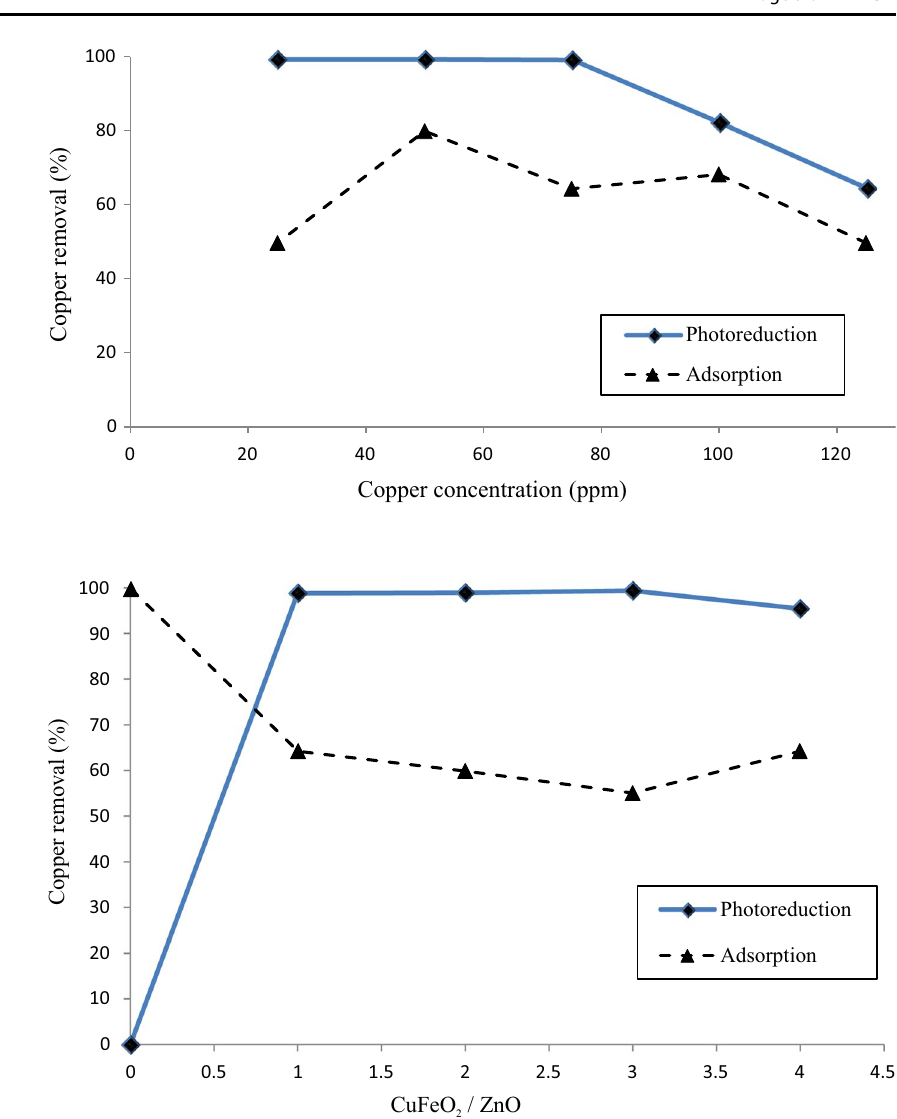
Fig. 5 Percentage of Cu 2+ reduction versus initial pollutant concentration